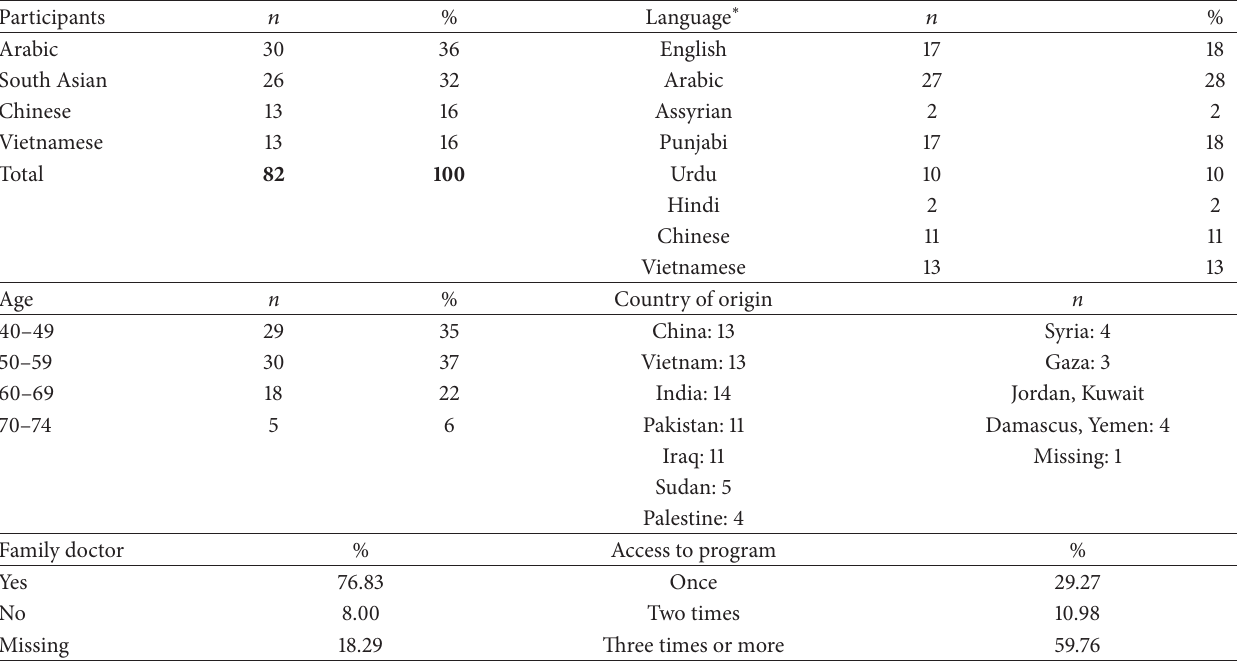
Table 2: Characteristics of immigrant women